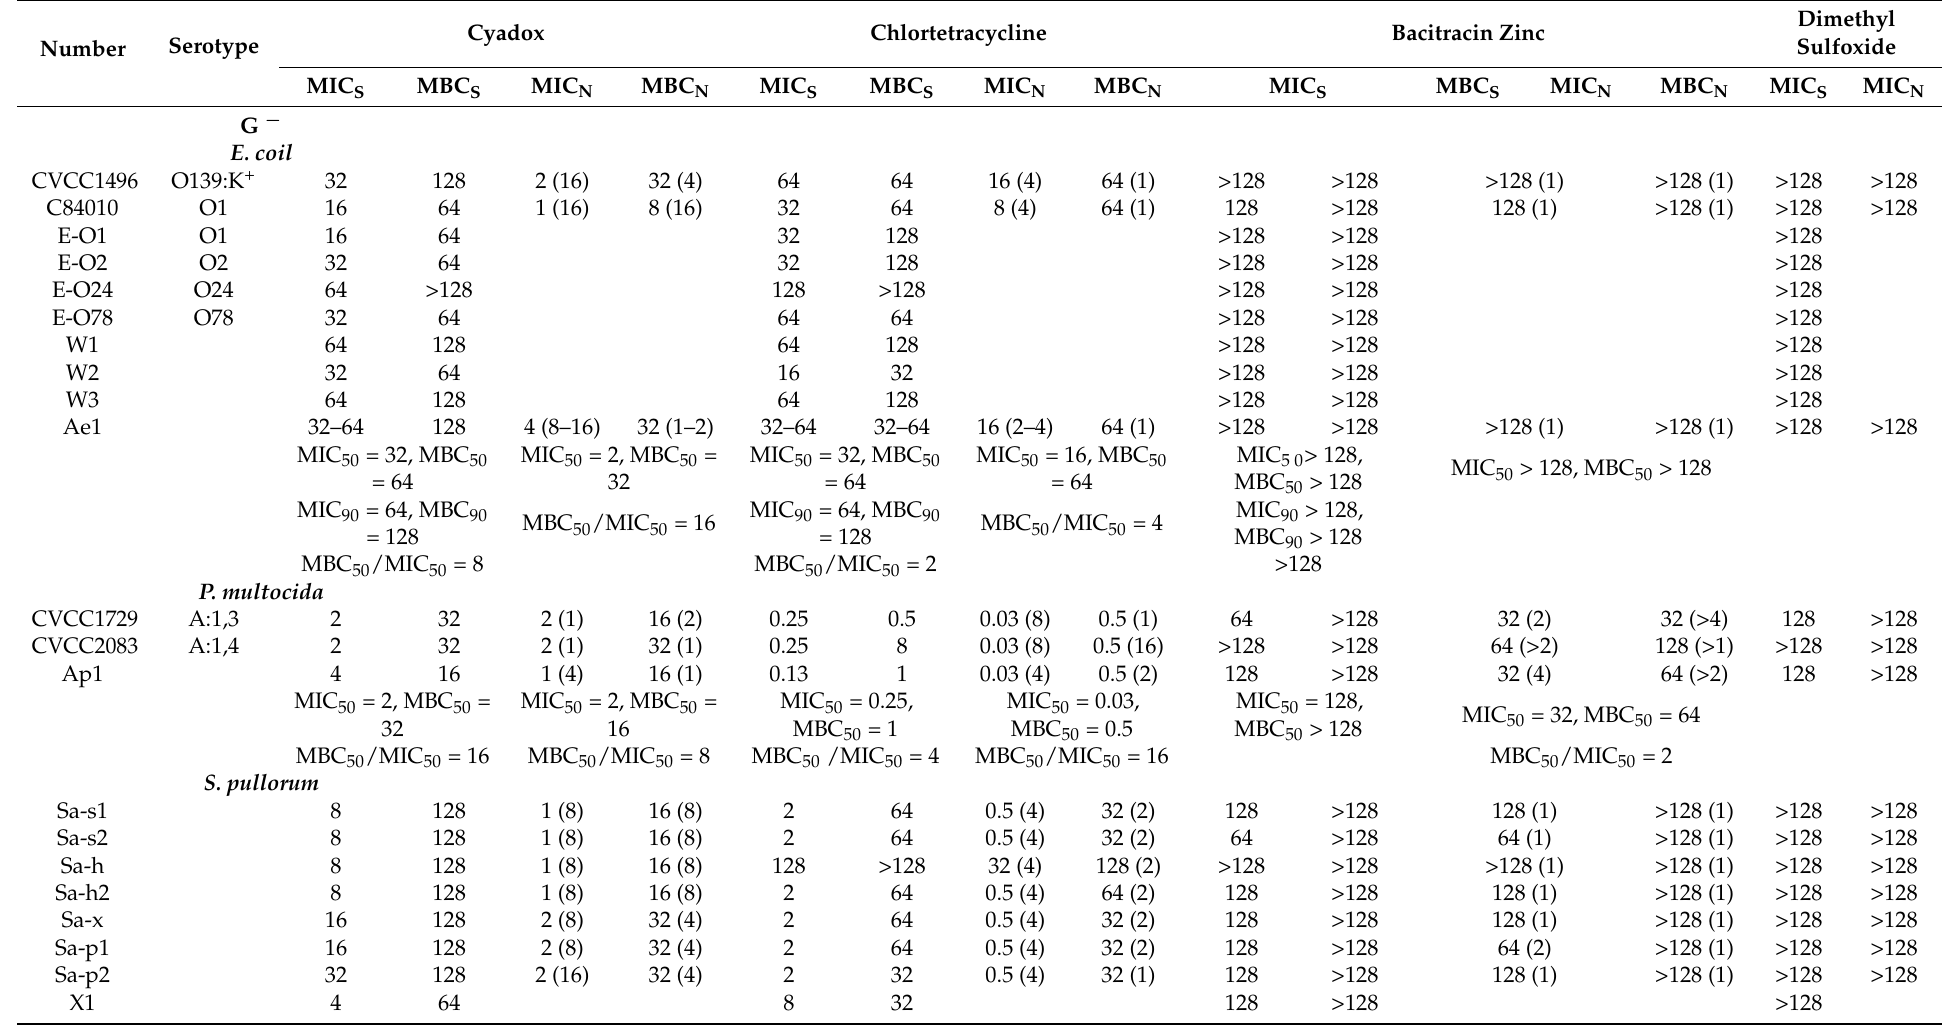
Table 2. Antimicrobial susceptibility of cyadox and controls against pathogens isolated from poultry (unit: µ